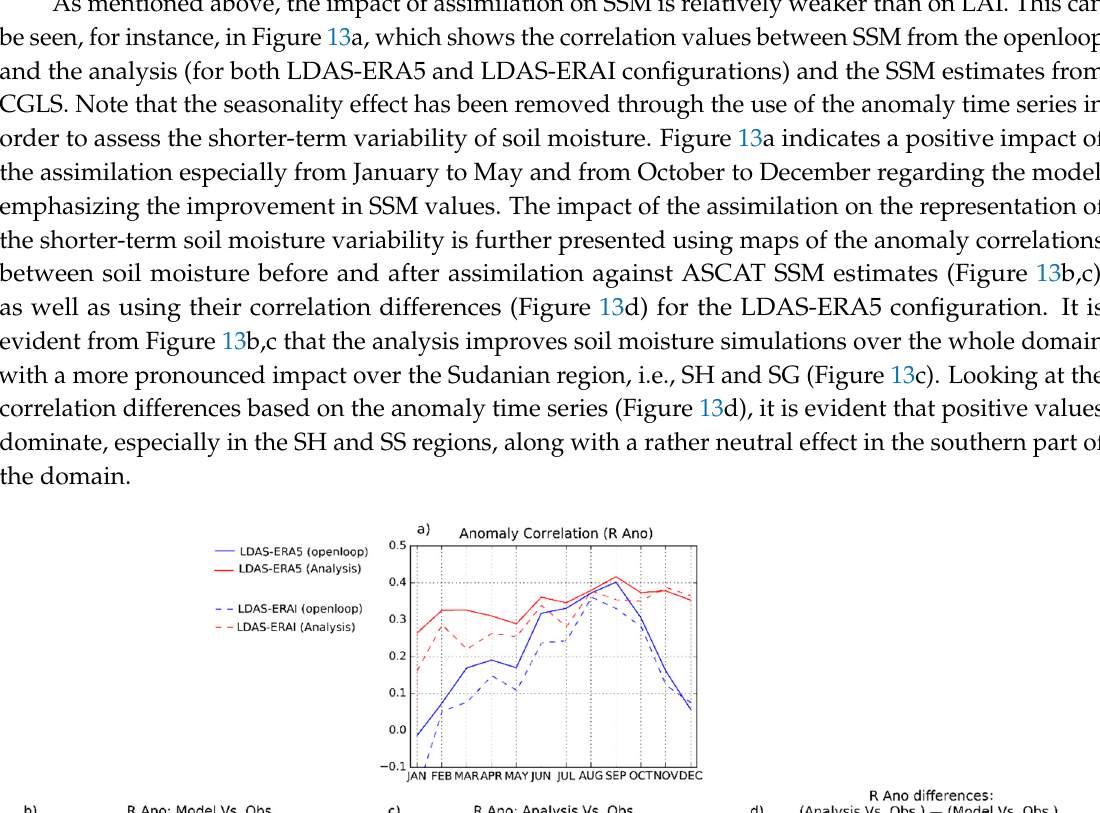
Figure 13. Seasonal correlations for ( a ) anomaly time series between SSM estimates from the CGLS project and SSM from the second layer of soil of ISBA LSM (in blue) and the assimilation (in red) over the period of 2007–06/2018 for both the LDAS-ERA5 and LDAS-ERAI configurations. ( b , c ) Maps of the anomaly correlation between SSM of the model, the analysis, and the SSM estimates from CGLS, respectively, ( d ) map of the correlation differences. ( a – c ) are for the LDAS-ERA5